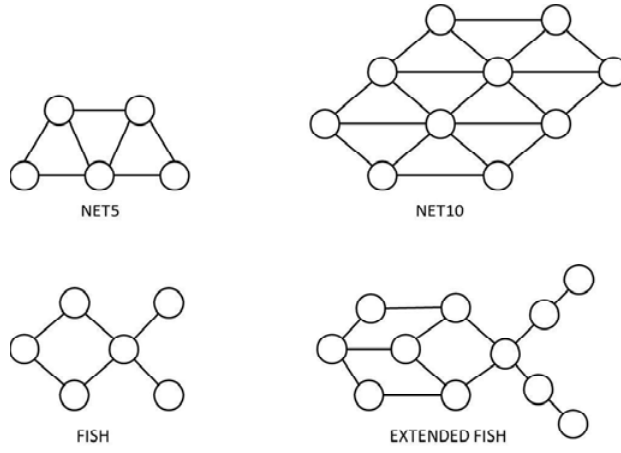
Figure 6. Network topologies used in the